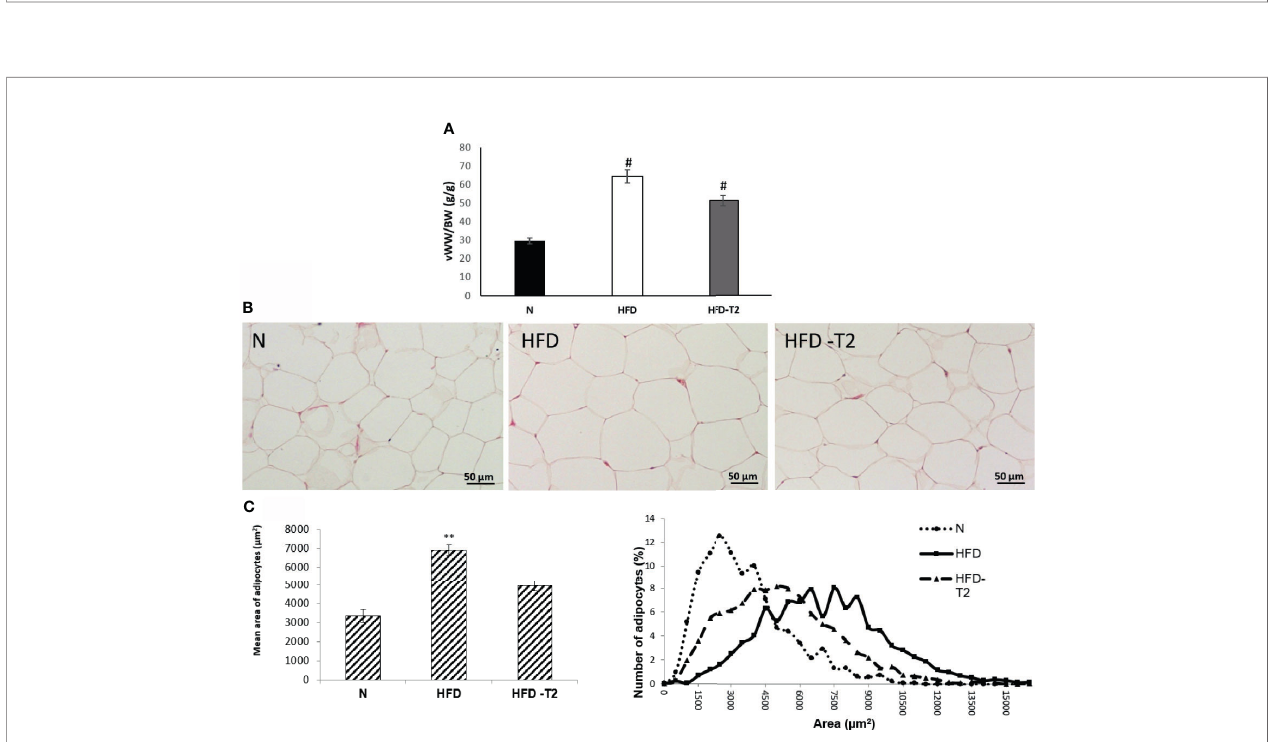
FIGURE 2 | Effects of T2 administration on visceral fat accumulation and on vWAT morphology. (A) Ratio of visceral white adipose tissue weight (vWW)/body weight (BW); (B) histological and (C) morphometrical analysis of visceral white adipocyte size. Representative staining of fi ve independent treatments are shown and were reproduced. Values are means ± SEM of fi ve independent experiments (n = 5), # P < 0.05 vs . N; **P < 0.05 vs. N and HFD – T2. N: rats receiving a standard diet for 14 weeks; HFD: rats receiving a HFD for 14 weeks; HFD-T2: rats receiving a HFD for 14 weeks with a daily administration of T2 during the last 4